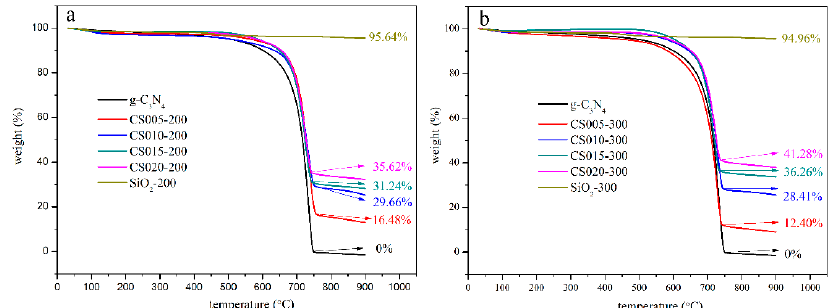
Figure 2. The TGA analysis of SiO 2 -200, g-C 3 N 4 , CS005-200, CS010-200, CS015-200, CS020-200 ( a ) and SiO 2 -300, g-C 3 N 4 , CS005-300, CS010-300, CS015-300, CS020-300 ( b ).